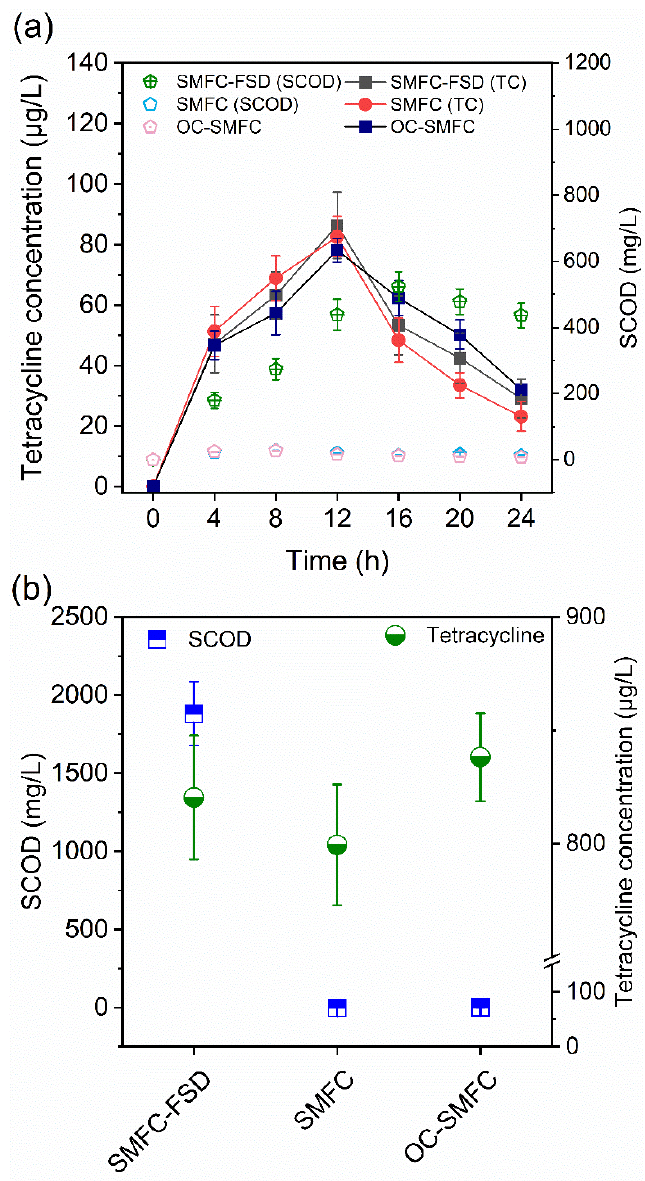
Figure 1. The concentration changes of soluble chemical oxygen demand (SCOD) and tetracycline concentration at the sampling point of the water tank during leaching process of SMFC-FSD were compared with those of SMFC ( a ). The final concentration of SCOD and tetracycline in the total leach solution of the two reactors after the leaching process ( b ).